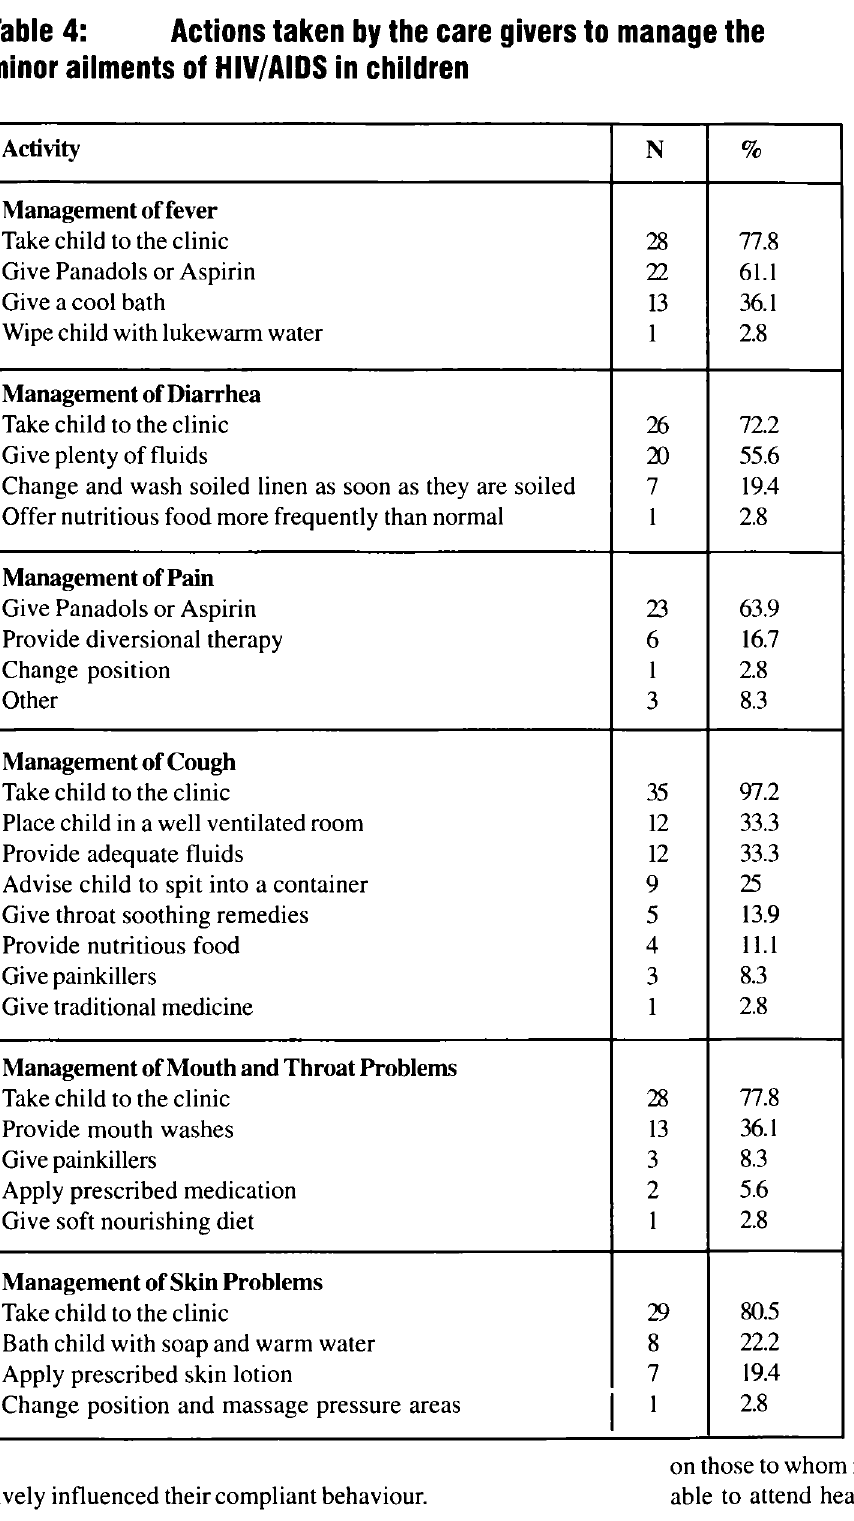
Table 4: Actions taken by the care givers to manage